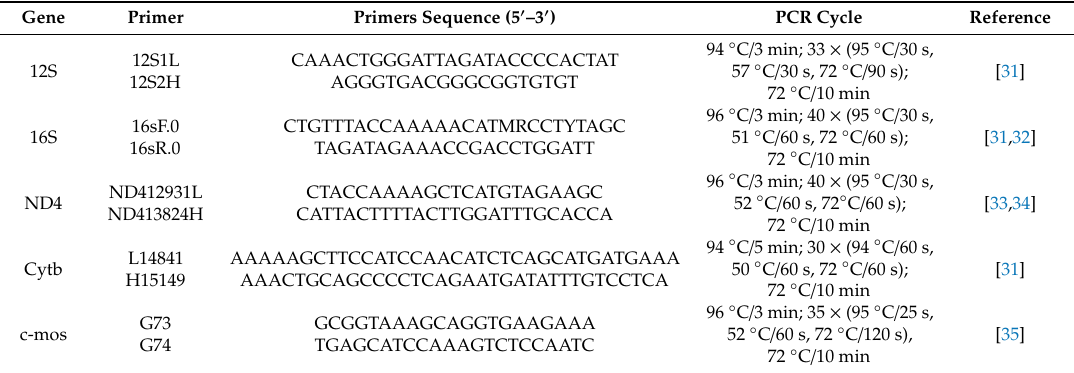
Table 2. List of primers used in this